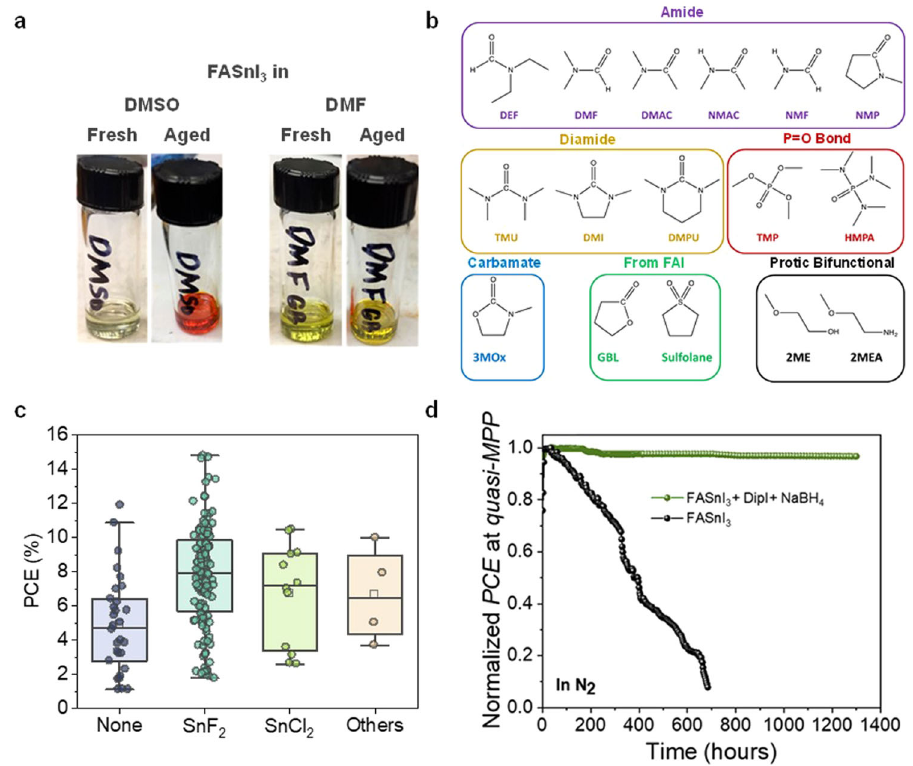
Fig. 5 Effects of solvents and additives on the photovoltaic performance and stability of Sn-HPSCs. a Fresh and aged (120°C for 5h) FASnI 3 solutions in DMSO and DMF. The colour change to red for aged DMSO solution suggests the presence of oxidised Sn species. b List of solvents capable of forming FASnI 3 solutions. c PCE distribution of reported devices in literature containing different SnX 2 additives. d Normalised PCE evolution at MPP in N 2 atmosphere of devices based on FASnI 3 perovskite with and without Dipl + NaBH 4 antioxidant additive strategy. (Fig. 5a adapted with permission from ref. 6 , Copyright 2020 ACS Publications. Figure 5b adapted with permission from ref. 77 , Copyright 2021 ACS Publications. Fig 5d reprinted with permission from ref. 96 ., Copyright 2022